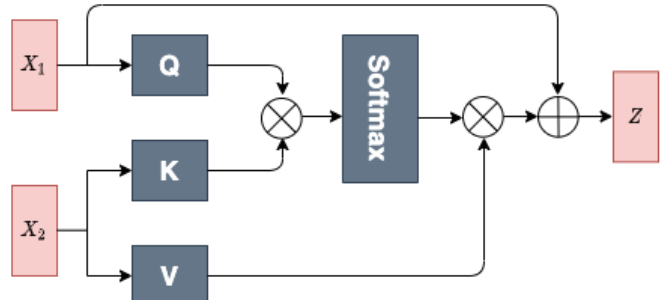
Figure 4. Multi-head cross-attention